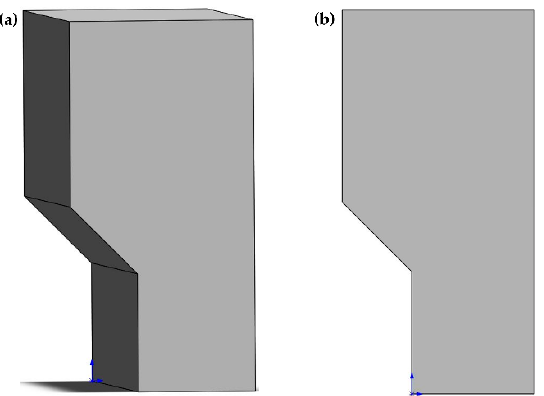
Figure 3. Three dimensional model and section of simulated chute: ( a ) three dimensional model; ( b ) section.